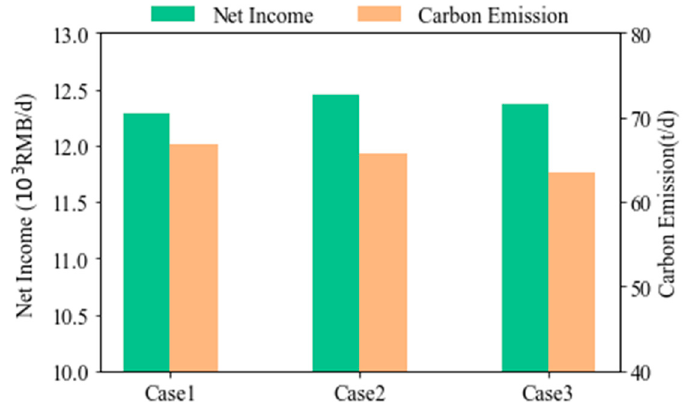
Figure 13. The benefits of operator in winter.